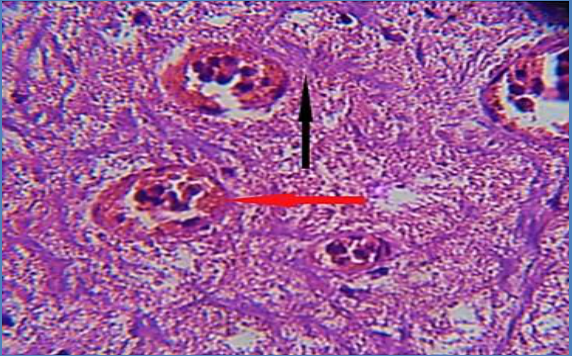
Figure, 10: Micrograph of goat group A shows increase thickness of capsular area (red arrow) granulation tissue (black arrow) at 15 th day postoperative (H and E 10 X).